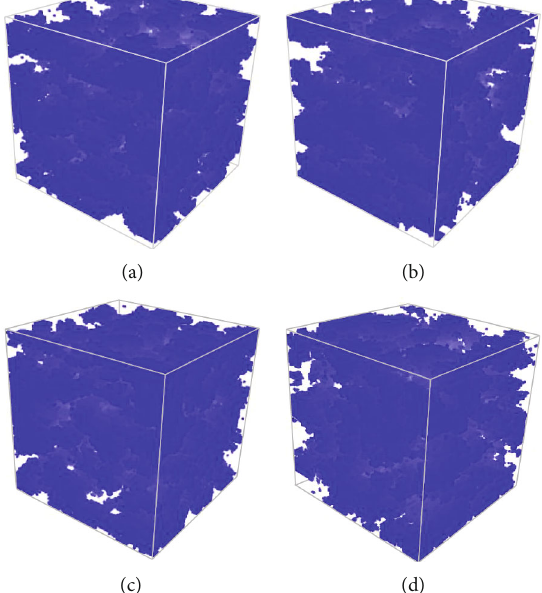
Figure 14: Reconstructed pore spaces of shale using (a) DTL; (b) SNESIM; (c) FILTERSIM; (d)